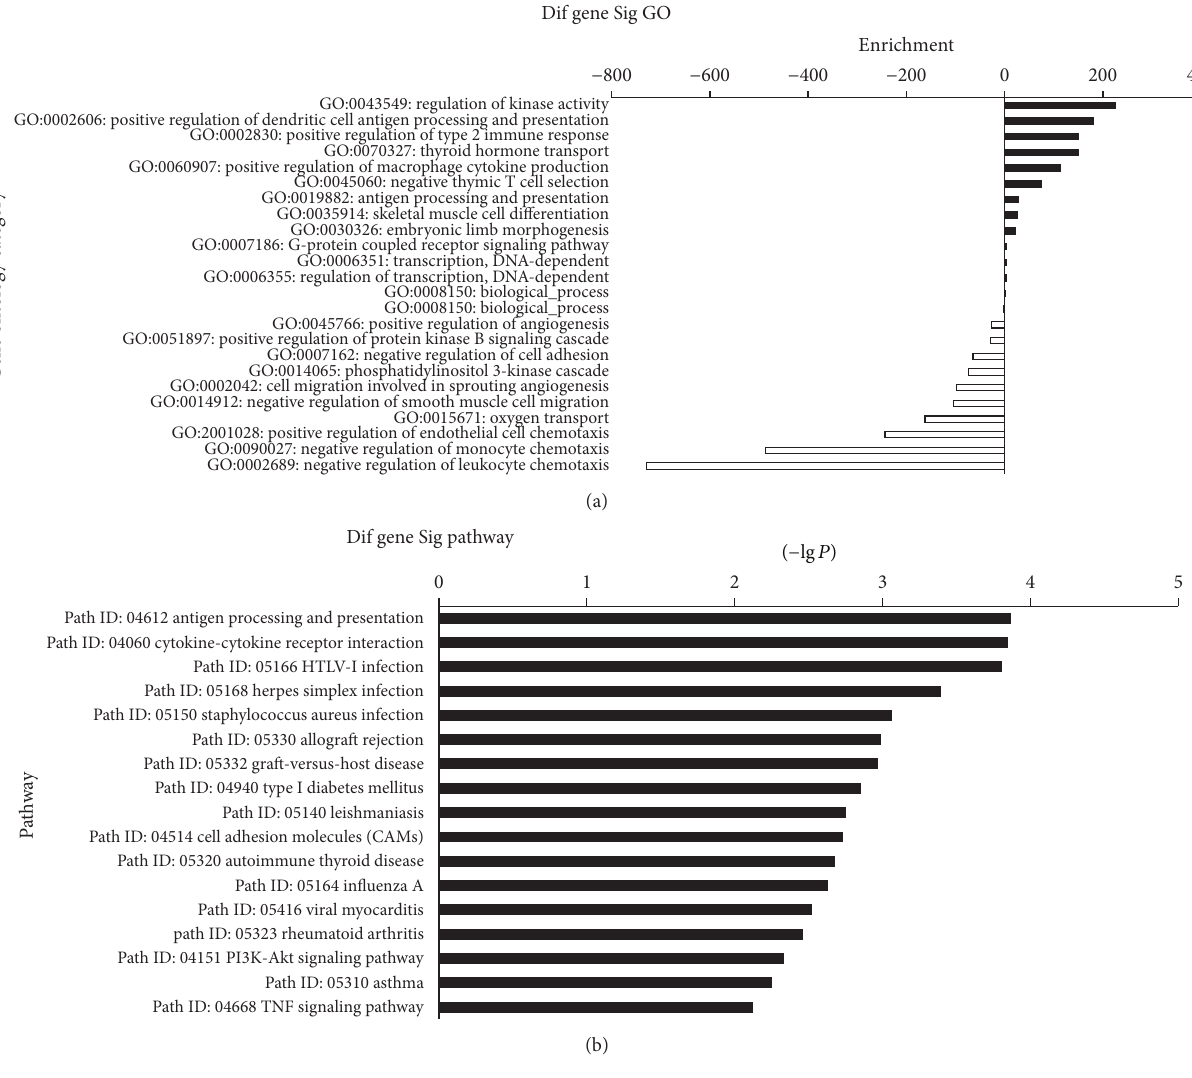
Figure 6: The significant enriched GO terms and